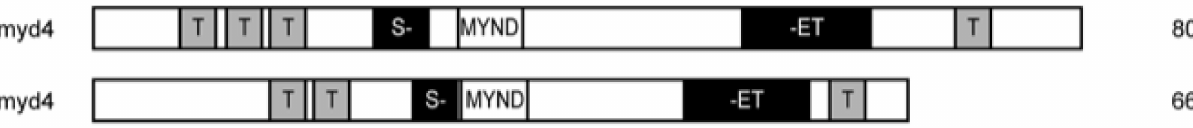
Figure 10. Domain structures of both the human SMYD4 and the Drosophila homologue, dSMYD4. Image licensed under CC-BY 4.0 Ref.